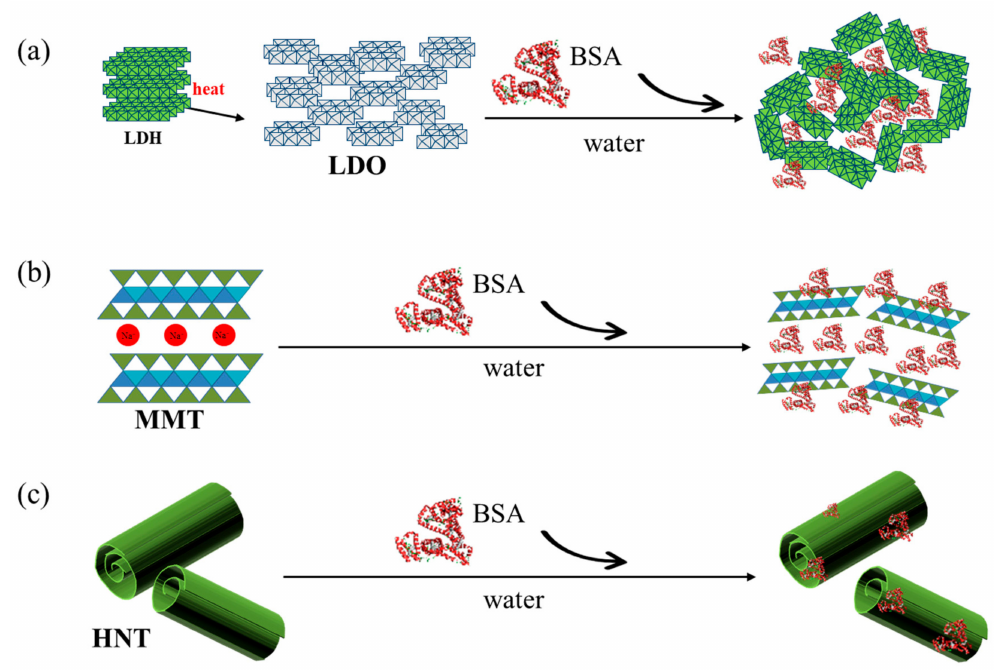
Figure 1. Schematic diagram for interactions between bovine serum albumin and clays: ( a ) layered double oxide (LDO), ( b ) Montmorilonite (MMT) and ( c ) Halloysite nanotube